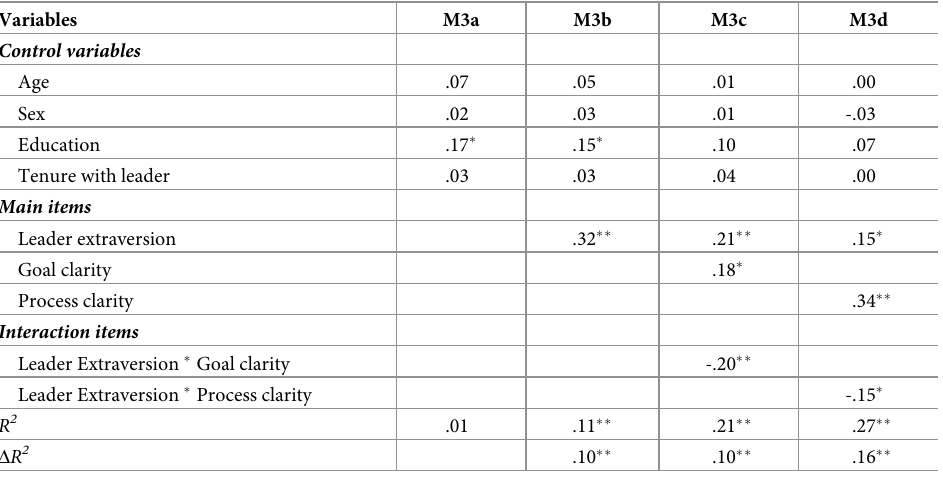
Table 5. Moderating effect of goal clarity and process